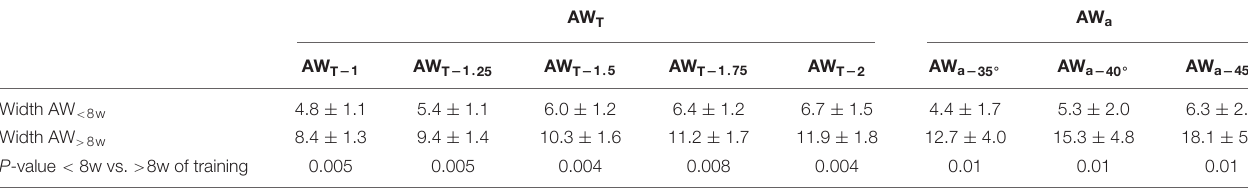
TABLE 3 | Assessment of the aerobic window across all horses using both mathematical approaches: the threshold (AW T ) and the angular (AW a ) approach. AW T AW a